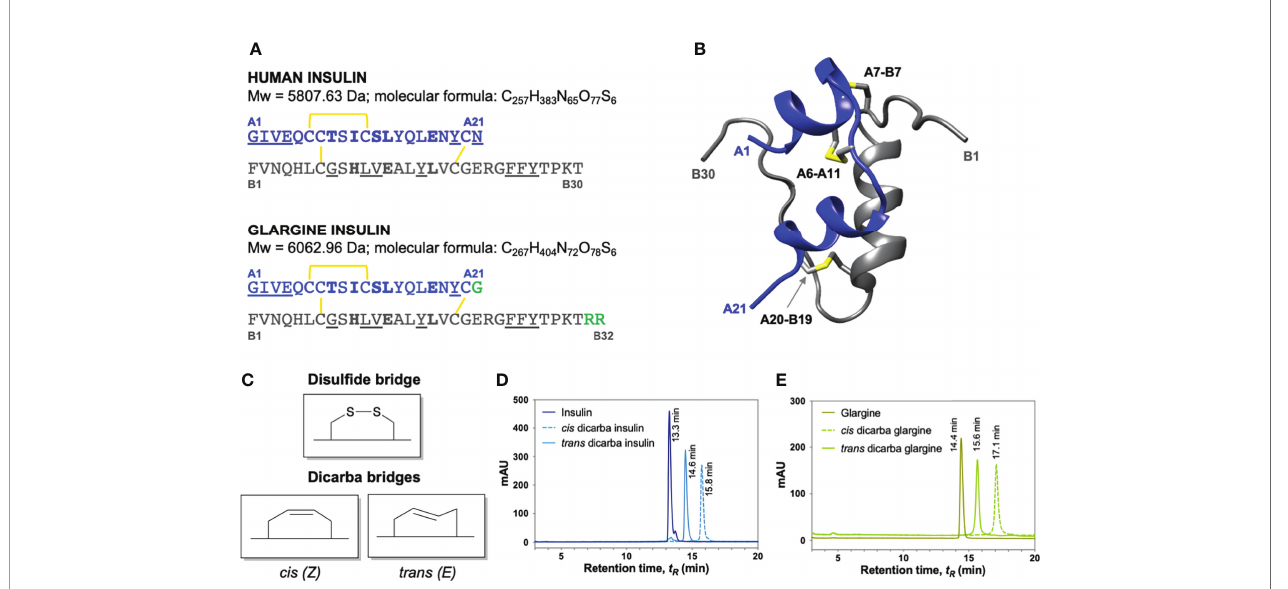
FIGURE 1 | Insulin, insulin glargine and dicarba insulin analogues. (A) Primary sequence comparison of human insulin (top) and insulin glargine ( bottom ). Both consist of A ( blue ) and B ( grey ) chains stabilized by three disul fi de bridges (yellow). Underlined are site 1-binding residues and bold are site 2-binding residues (8). Long-acting insulin glargine has a substitution of AsnA21 ➛ GlyA21 residue and an addition of ArgB31 ArgB32 residues on the C -terminal end of B chain (highlighted in green ). (B) Ribbon diagram of human insulin (2-Zn-coordinated T 6 conformation PDB entry 1MSO) showing the location of the three a -helices ( A chain: blue; B chain: grey ) and the three disul fi de bonds ( yellow ). (C) Schematic diagram of native cysteine and isomeric cis- and trans- dicarba bridges. RP-HPLC chromatograms of (D) insulin, cis- dicarba insulin and trans- dicarba insulin (9); (E) insulin glargine, cis- dicarba dicarba glargine and trans- dicarba glargine. Analysis of the fi nal synthesis products by mass spectrometry con fi rmed the correct masses of dicarba insulin (5766 Da) and dicarba insulin glargine (6021